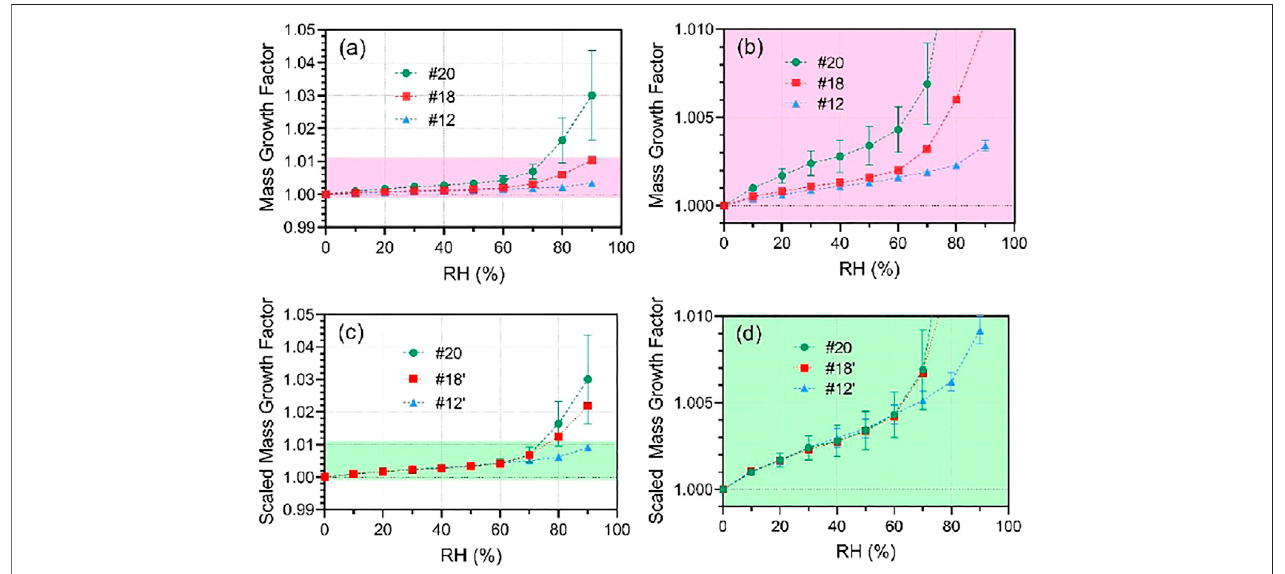
FIGURE 7 | (A) Mass growth factor (m/m 0 ) as a function of RH. (B) Zoomed-in, (C) scaled, and (D) scaled and zoomed-in mass growth factors. Sample #18 is scaled by a factor of 2.1 and sample #12 is multiplied by 2.7 to overlap with sample